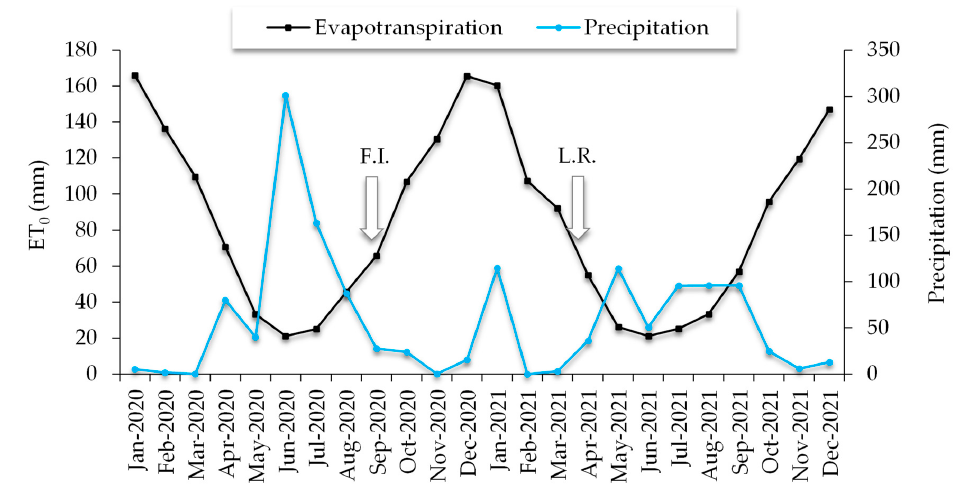
Figure 2. Irrigation period for calafate plants: FI: First irrigation; LR: last watering, based on reference evapotranspiration (ET 0 ) and precipitation, according to information from the agroclimatic station of the Instituto de Investigaciones Agropecuarias (INIA Quilamapu), Chile. Soil volumetric water content (%) was monitored every 15 days (Table 2) with a Diviner 2000 portable soil moisture probe (Sentek, Stepney, Australia) that provides the soil moisture value in percent, from November 2021 to February 2022. The statistical design was randomized complete blocks. Soil microbiological, plant physiological and fruit chemical analyses were determined only once at the end of the harvest period, during the month of January. Samples were taken from each experimental unit, where the experimental unit consisted of the average of two subsamples, each subsample being a calafate plant, and four replicates per treatment ( n = 16) were carried out in all blocks. Table 2. Soil moisture monitoring with a frequency of 15 days.